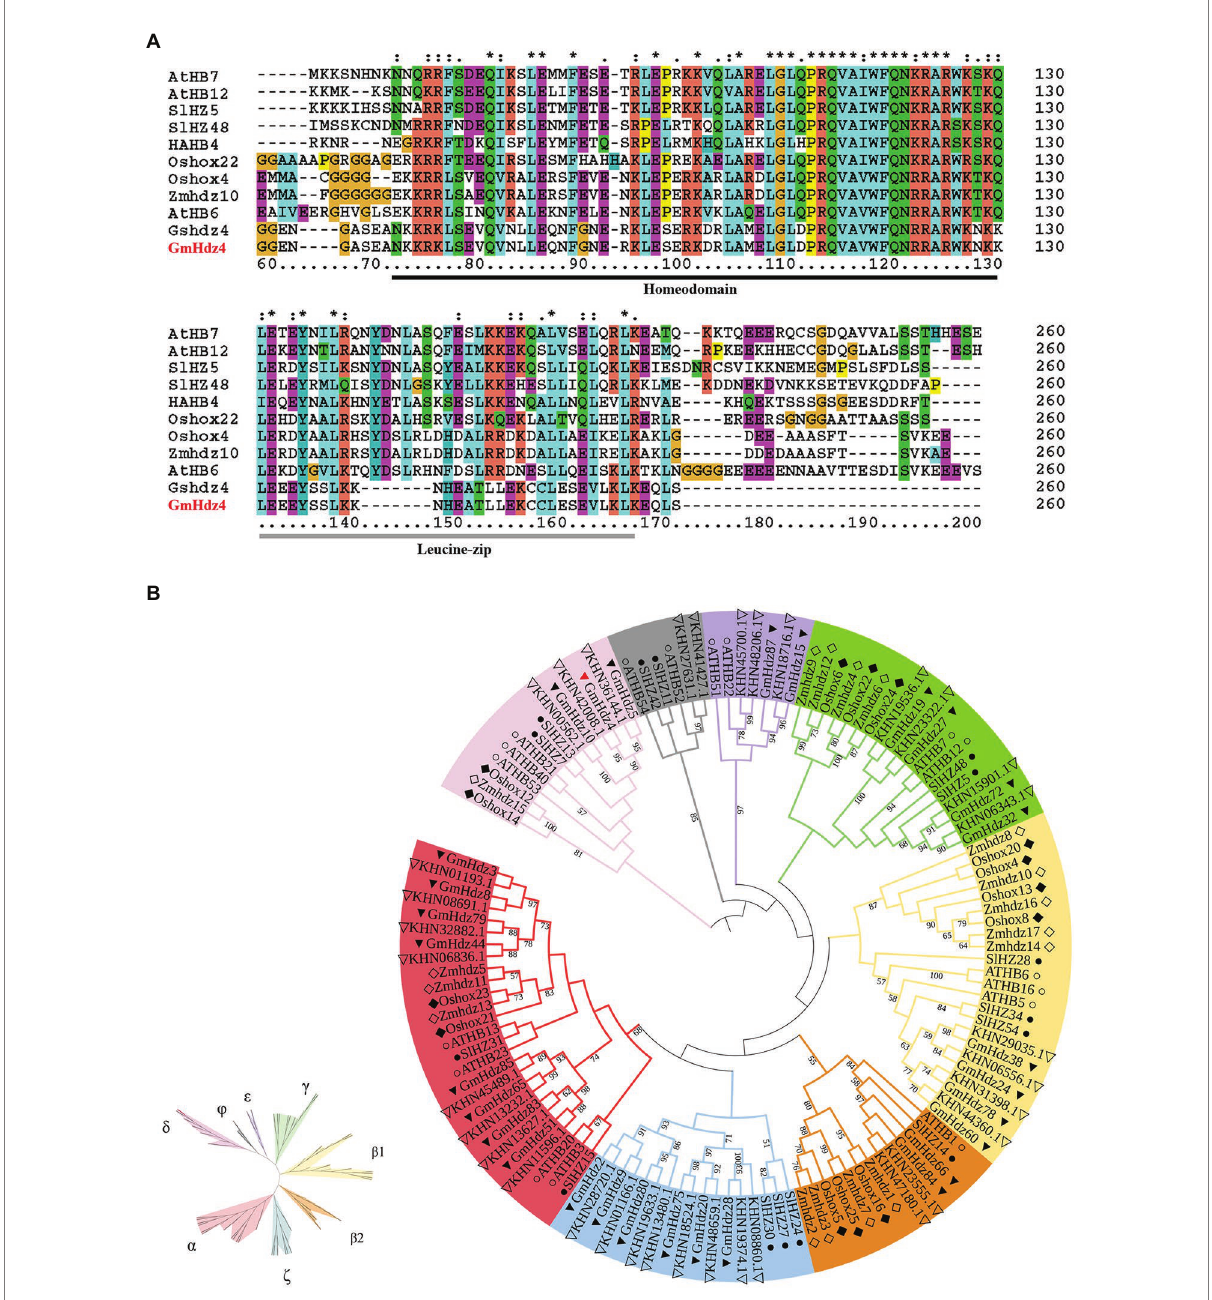
FIGURE 1 Sequence alignment and phylogenetic analysis. (A) Multiple sequence alignment for GmHdz4 and other drought stress-related HD-Zip I proteins. HD and LZ domains are underlined by black and gray, respectively. The corresponding IDs of Oshox22, Oshox4, AtHB7, AtHB12, AtHB6, Gshdz4, GmHdz4, HAHB4, Zmhdz10, SlHZ48, and SlHZ5, are Q7XUJ5.2, Q6K498.1, P46897.2, Q9M276.1, P46668.1, AOG74801, Glyma11g06940, XP_022022563, AFT92045, XP_004245456, and XP_004230017, respectively. (B) Phylogenetic analysis of HD-Zip I transcription factors from Arabidopsis , rice, maize, tomato, soybean, and wild soybean. The phylogenetic tree was built using NJ method in MEGA. Bootstrap support is indicated on the branches. Genes from each of the species are marked with different symbols: Arabidopsis ( ○ ), rice ( ■ ), maize ( □ ), soybean ( ▼ ), wild soybean ( ▽ ), and tomato ( ●